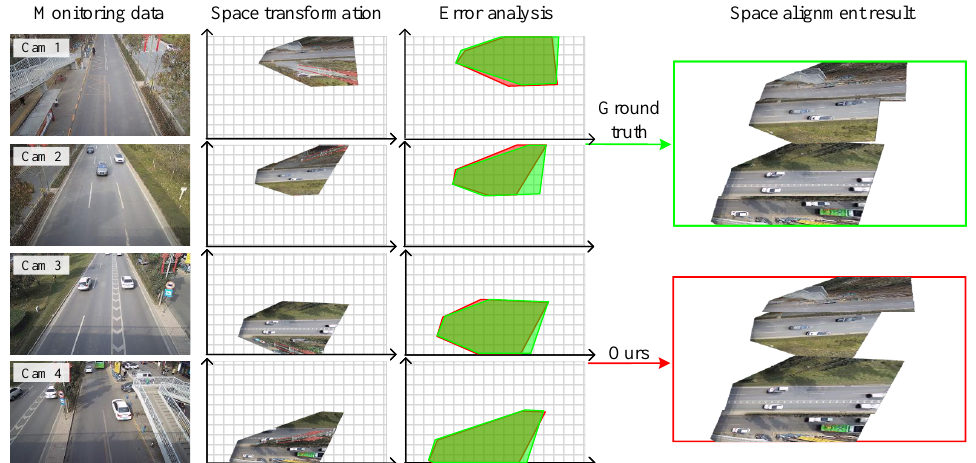
Figure 10. Some qualitative evaluation results of our proposed approach on real environment. The real monitoring scene is two-way multi-lane traffic system with main and side road. Our space alignment results are shown in turn, including the monitoring data, space transformation and the comparison with ground truth. In these results, the ground truth is marked in green and our results are marked in